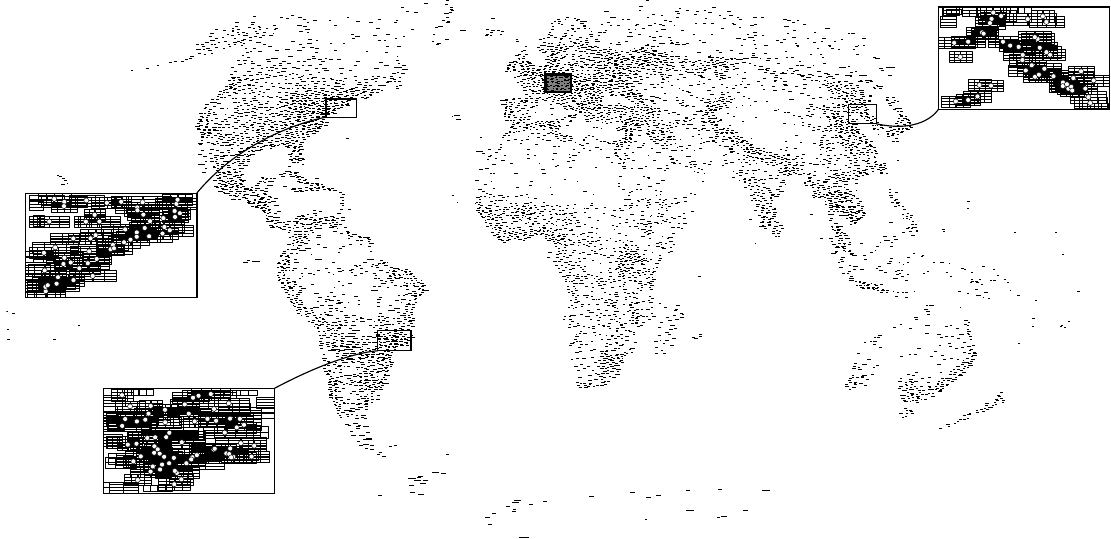
Figure 8. The labels of a solution for the instance that we generated from an existing data set, using the eight-position model. In the three magnified rectangles all point features and label candidates in the corresponding region of the map are displayed. The gray shaded rectangle is magnified in Figure